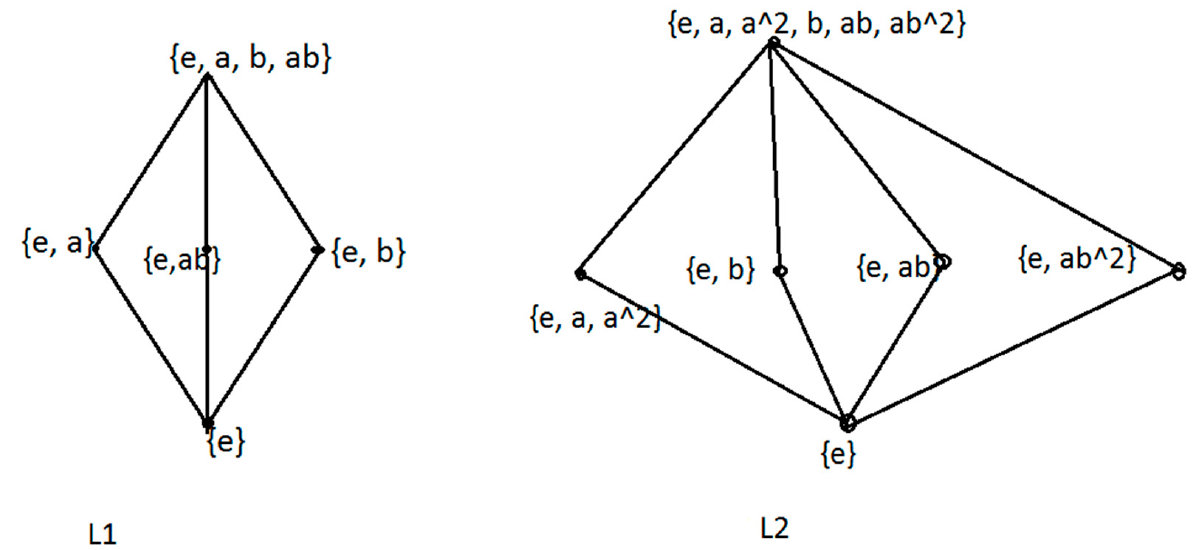
Figure 1. Complete bounded but non-distributive lattices.